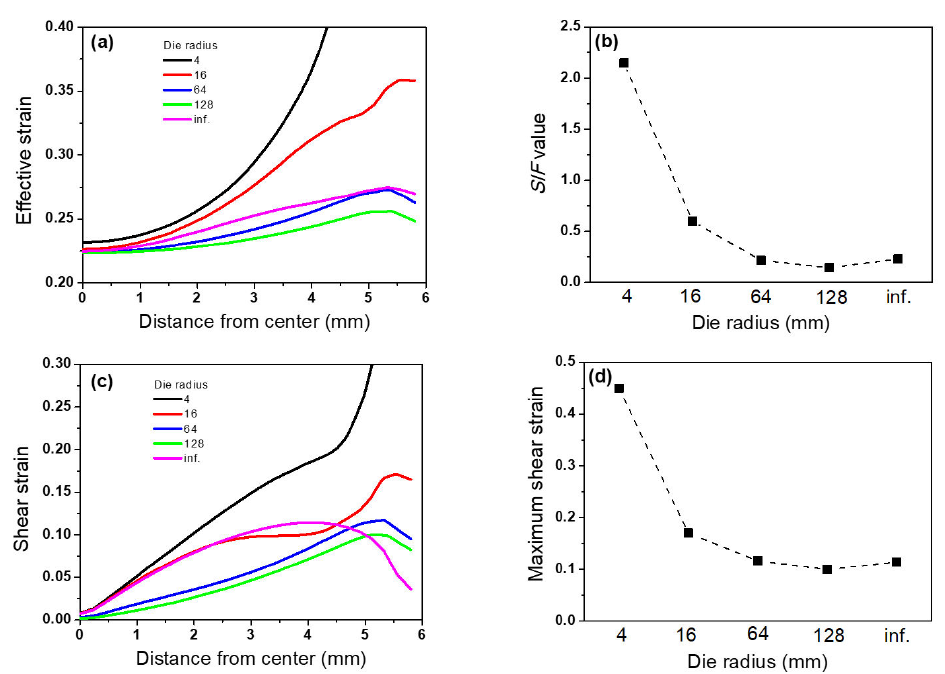
Figure 7. Comparison of ( a ) effective strain profile along the radial direction, ( b ) SIF value, ( c ) shear strain profile along the radial direction, and ( d ) the maximum shear strain of the wire with the die